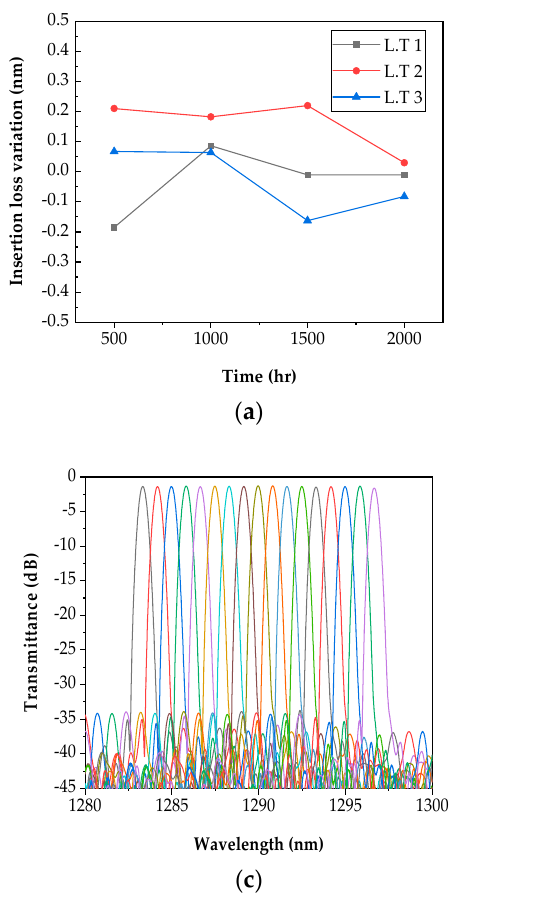
to − 5 dB transmission (L. T. 1).